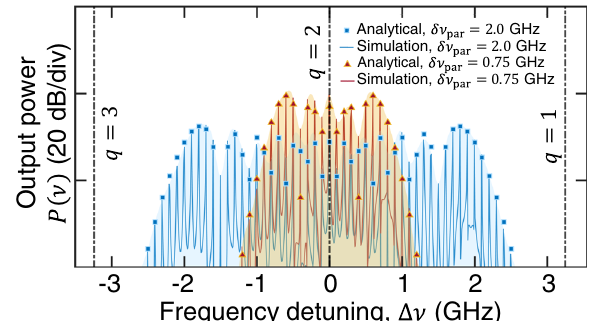
Fig. 2 Optical frequency combs (OFCs) generated by the spatially uniform adiabatic modulation of a parabolic SNAP bottle microresonator. The blue and red lines correspond to the OFC spectrum obtained from numerical solution of Eq. (3) for constant modulation amplitudes δ ν par ¼ 2 GHz (blue line) and δ ν par ¼ 0 : 75 GHz (orange line), respectively. In both ¼ 1 : 2 ´ 10 7 . The blue squares and the orange cases, the Q-factor is Q q 0 triangles correspond to the spectrum found from Eq. (8) for δ ν par ¼ 2 GHz and δ ν par ¼ 0 : 75 GHz,